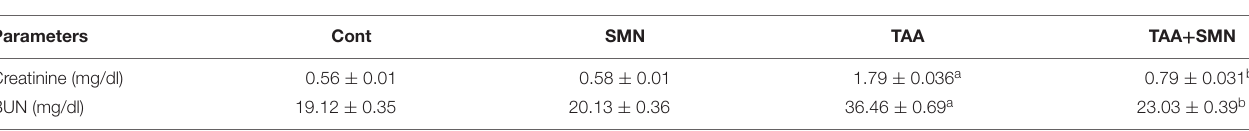
TABLE 2 | Effect of TAA and SMN on renal markers.